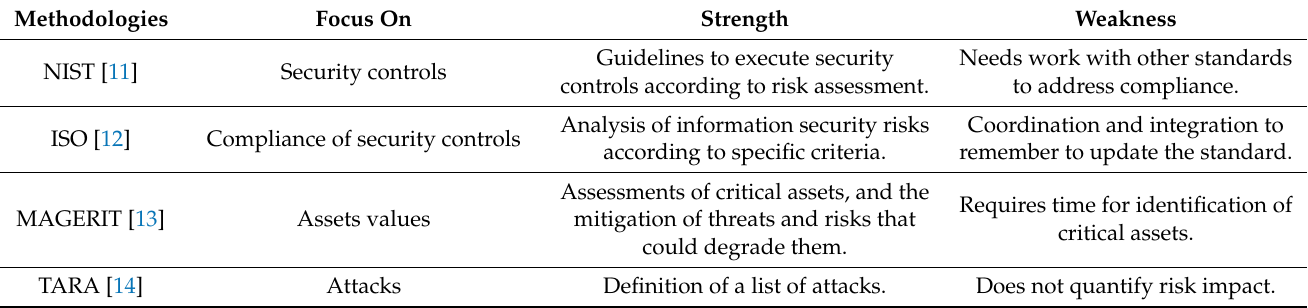
Table 1. Strengths and weaknesses of risk methodologies used in computer